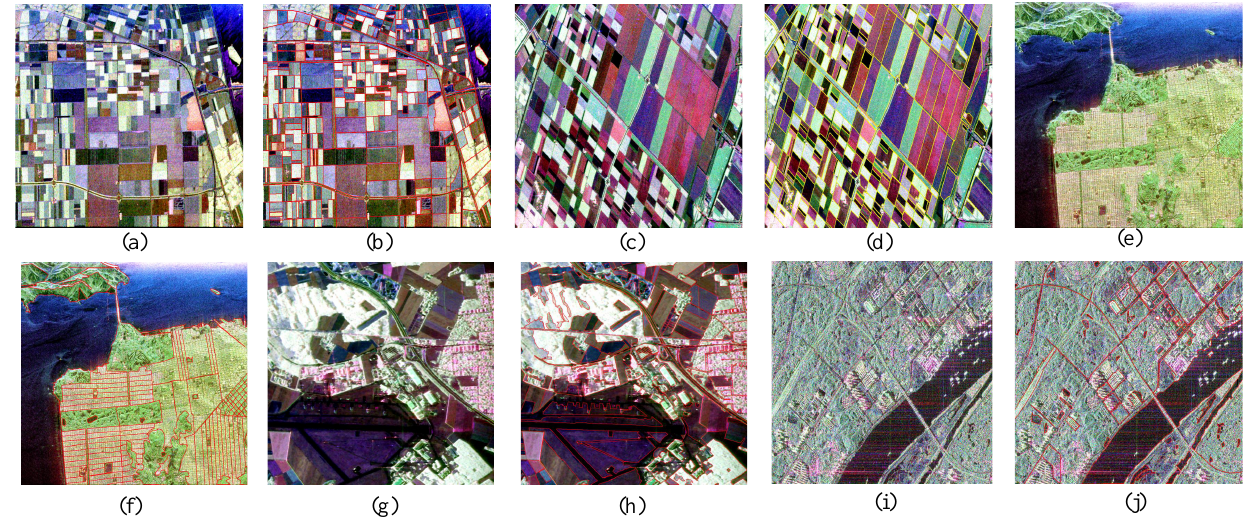
Figure 8. Data sets 1–5. ( a , c , e , g , i ) are the Pauli-RGB images of data sets 1–5. ( b , d , f , h , j ) are ground- truth maps of data sets 1–5. Table 1. Some information on experimental PolSAR data